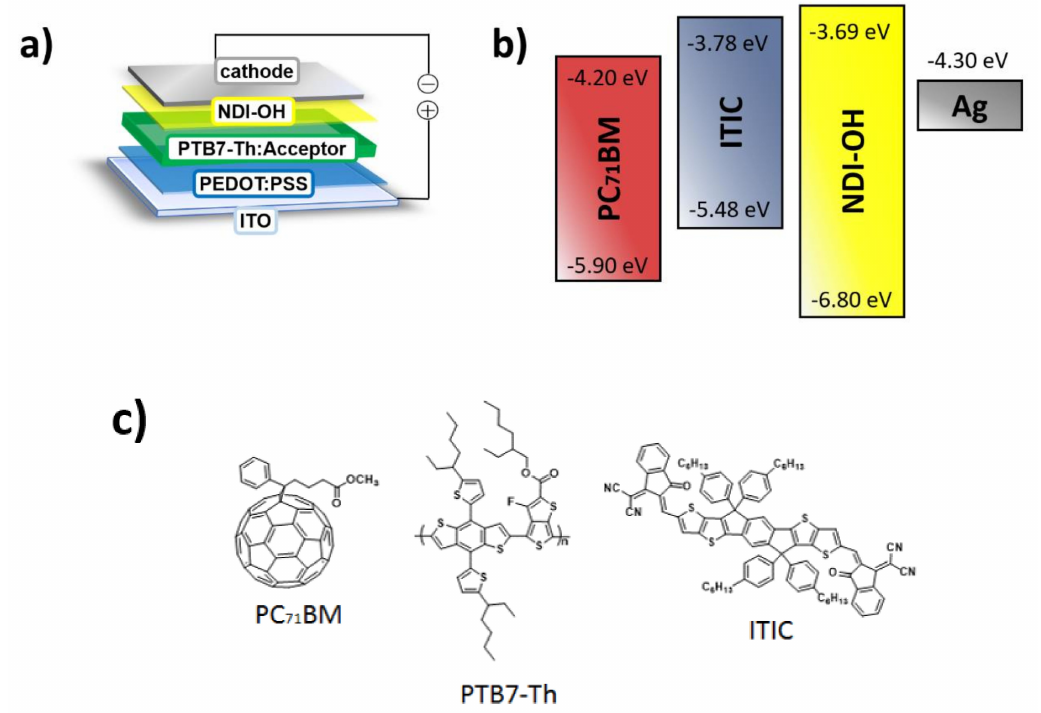
Figure 3. ( a ) Device architecture ( b ) energy level and ( c ) structures of polymers and molecules used as active layers.